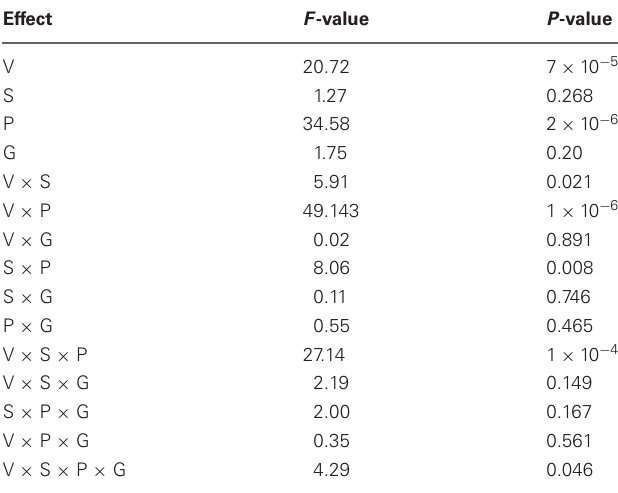
Table 3 | Modulation of visual analog scale